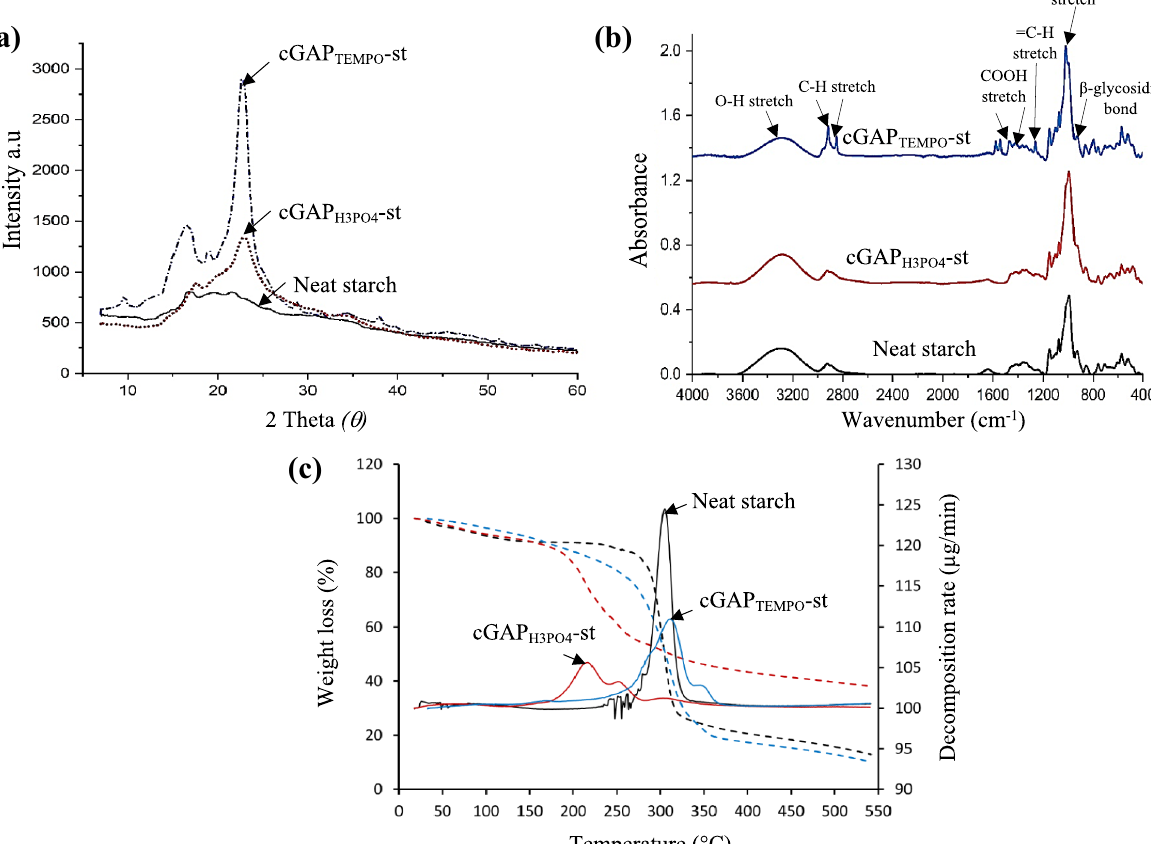
Fig. 5 Profile of a XRD; b FTIR; and c thermal properties analysis of neat starch, cGAP H3PO4 -st and cGAP TEMPO -st